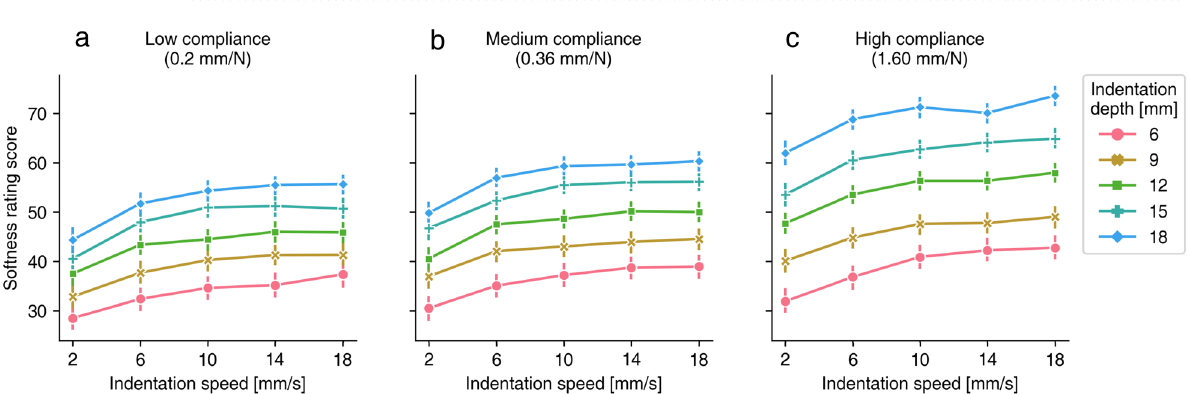
Figure 2. ( a – c ) Softness rating scores for each indentation speed and indentation depth in the case of the material with ( a ) low compliance, ( b ) medium compliance, and ( c ) high compliance. Error bars denote